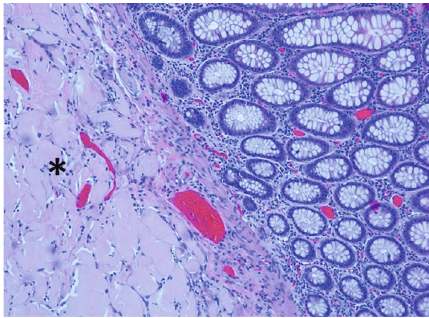
Figure 3: Gel with mucin-like appearance ( ∗∗ ) and associated in fl ammation present in expanded submucosa. H and E stain × 20.